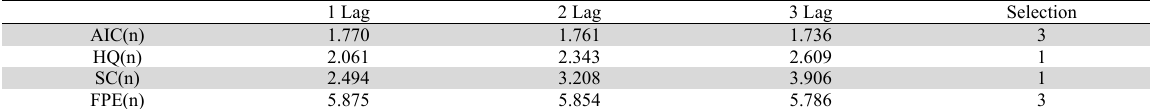
Information Criteria Lag Selection